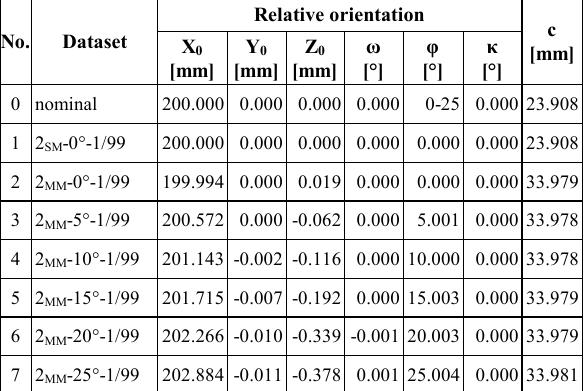
Table 2. Relative orientation and principal distance as a